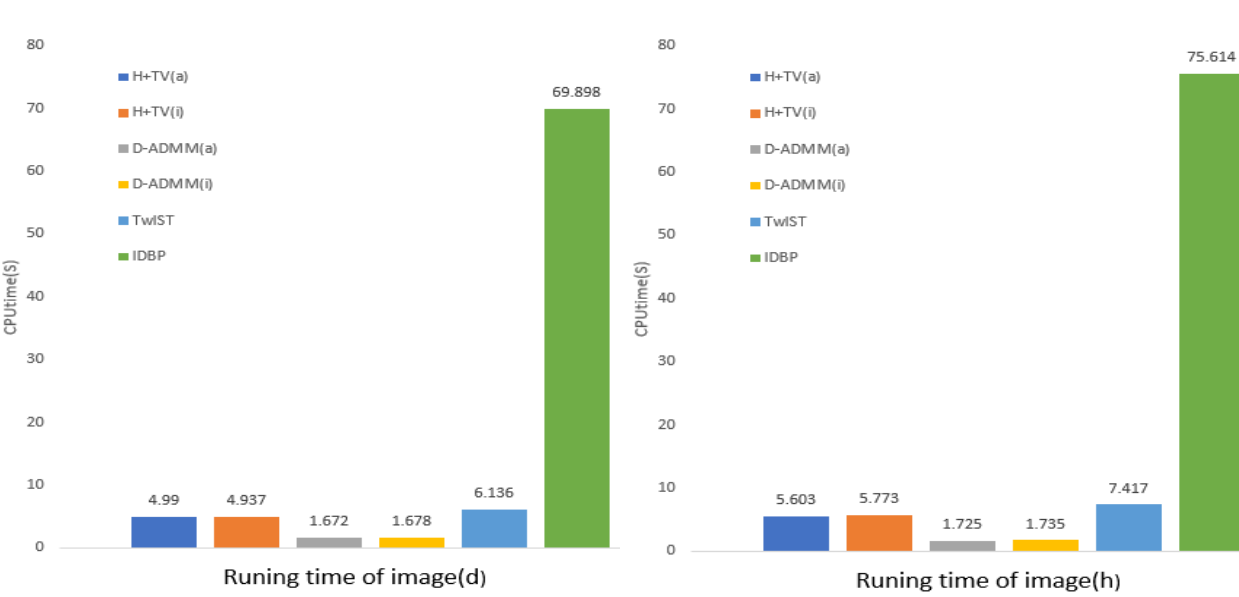
Figure 5. Running time comparison of different